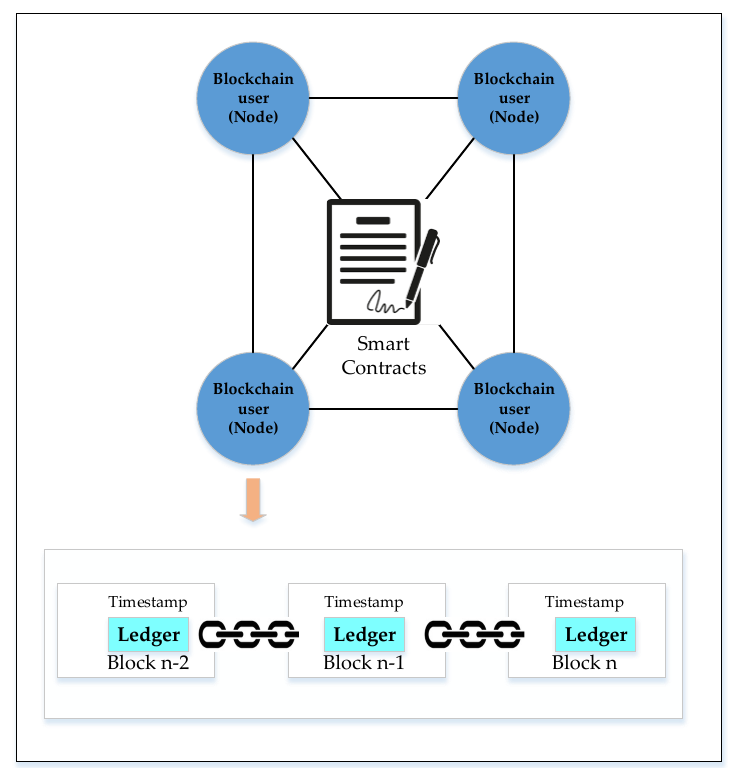
Figure 4. A simple architecture of blockchain technology.